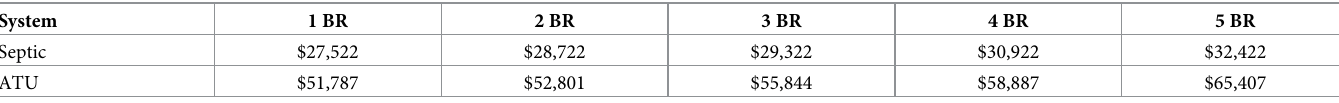
Table 3. Life cycle costs for septic and ATU